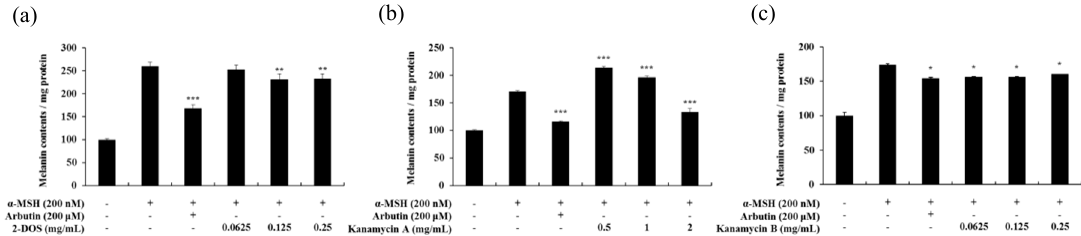
Figure 13. Melanin contents of 2-DOS( a ), kanamycin A( b ), and kanamycin B( c )-treated B16F10 melanoma cells. The cells were treated with various drug concentrations for 72 h. α -MSH was used as a negative control and arbutin was used as a positive control. Melanin concentrations are expressed as percentages compared to the respective values obtained for the control cells. Data are presented as mean ± standard deviation (SD) of at least four independent experiments ( n = 4). * indicates p < 0.05, ** p < 0.01, *** p < 0.001 vs. tobramycin treatment.